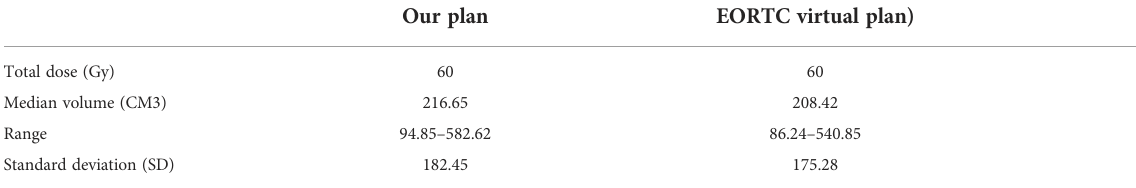
TABLE 4 Comparison of brain volume of high-dose radiation fi elds between our radiotherapy and EORTC virtual plan. Our